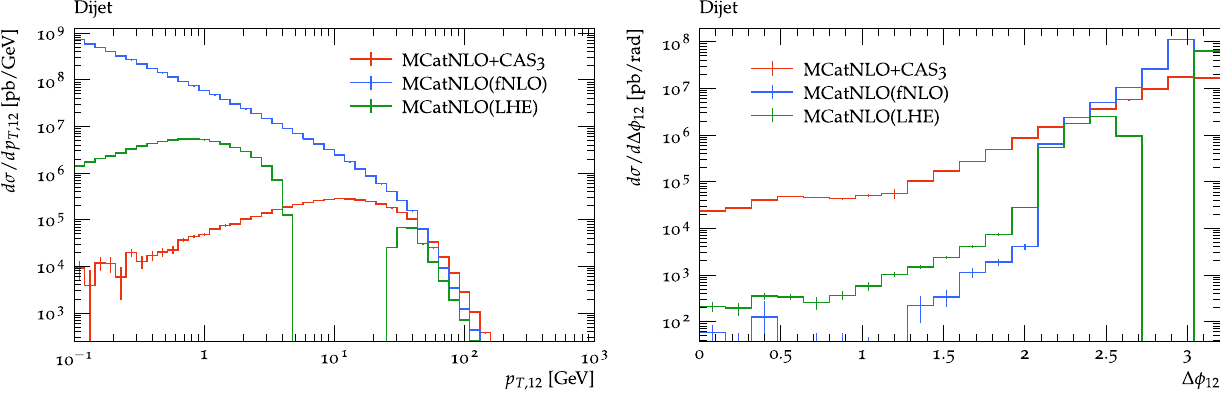
Fig. 3 Transverse momentum spectrum of the dijet system p T , 12 (left) and (cid:2)φ 12 distribution (right). The predictions are shown for fixed NLO (MCatNLO(fNLO), the (unphysical) LHE level (MCatNLO(LHE)) and after inclusion of PB-TMDs